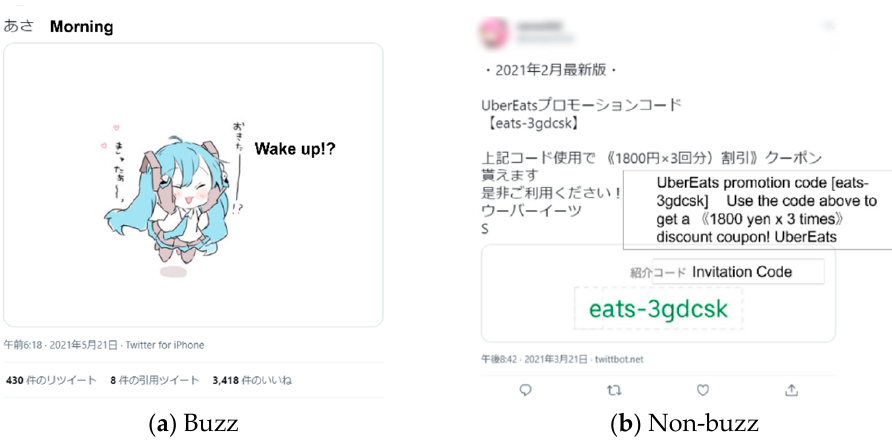
Figure 10. Examples of tweet pairs with high similarity in image features (with DenseNet).